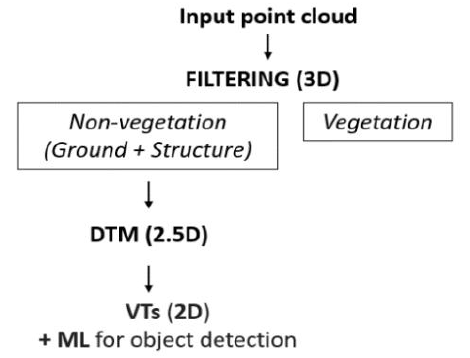
Figure 1. A typical pipeline for processing ALS datasets. The filtered 2.5D DTM is used with visualisation techniques (VTs) and machine learning (ML) methods to detect archaeological evidence.